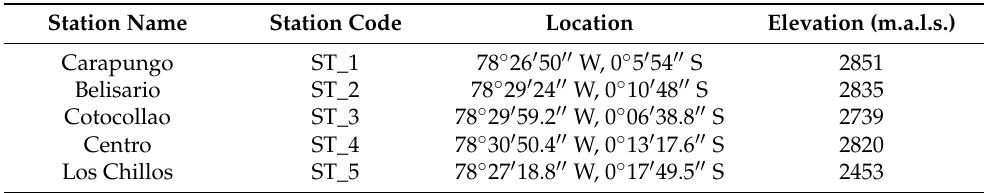
Figure 1. Wildfire event on 14 September 2015, obtained from the MODIS-Terra/Aqua sensor platform in Quito. The wildfires are represented by red points, and the monitoring stations by yellow points. Table 1. Monitoring stations for PM 2.5 and their main characteristics.